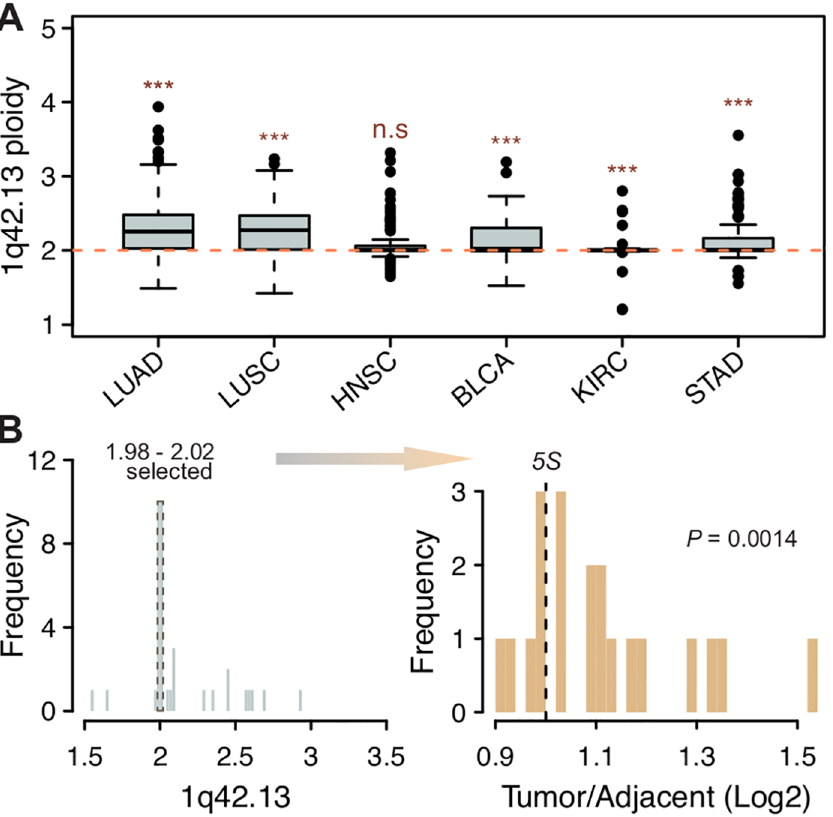
Fig 6. The 5S rDNA is increased through 1q42 segmental duplications and 5S array expansion. (A) Most cancers displayedsignificantly increased1q42.13ploidy.(B) Significant 5S CN amplification was still observedin STAD when only consideringpatients that are closest to diploidyat 1q42.13(P-value from one- tailed Wilcoxon rank sum test). Only patients with 5S rDNA CN estimated for both tumor and adjacent tissues are shown in